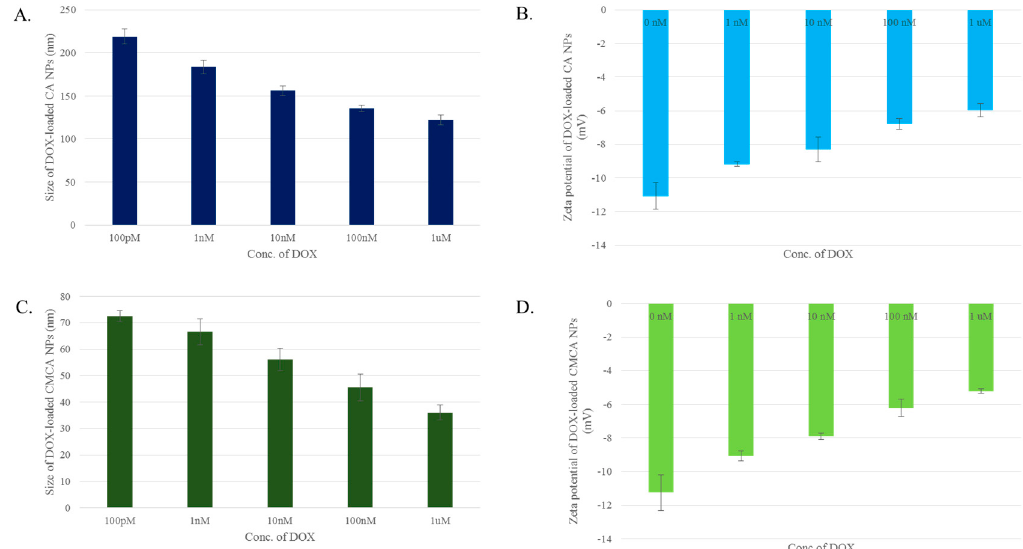
Figure 3. Size and zeta potential of DOX-loaded CMCA and CA NPs. ( A ) size of DOX-loaded CA NPs; ( B ) zeta potential of DOX-loaded CA NPs; ( C ) size of DOX-loaded CMCA NPs; ( D ) zeta potential of DOX-loaded CMCA NPs.